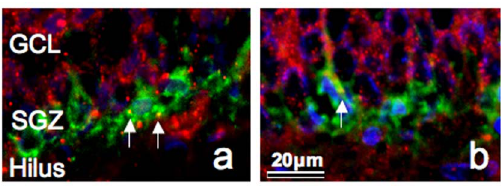
Figure 4. Fluorescent immunoreactivity of saposin B and PSA- NCAM. Light micrographs of the SGZ in the dentate gyrus at P28 stained with saposin B (red), PSA-NCAM (green) and DAPI (blue). Note that saposin B immunoreactivity (arrows) is frequently detected in PSA- NCAM-positive cells, where PS immunoreactivity is rarely observed.